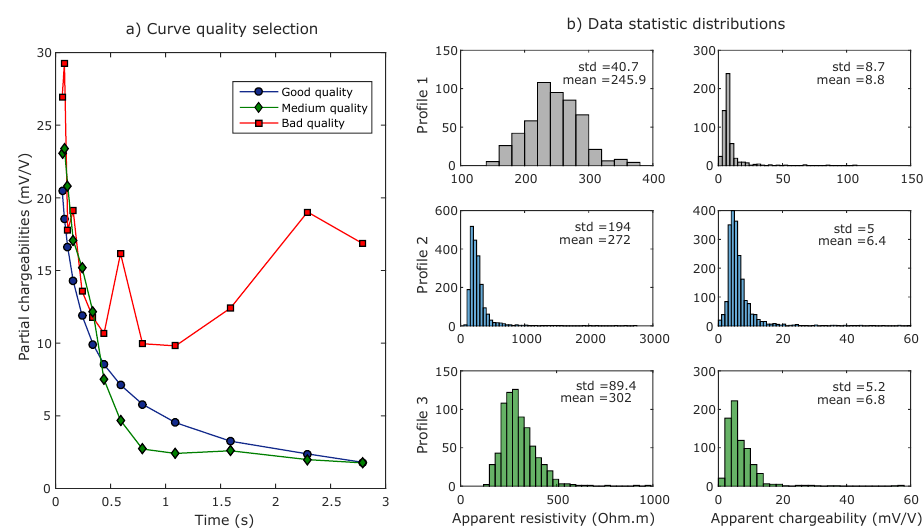
Figure 7. ( a ) Example of three chargeability curves indicating different data quality. The medium quality type of curve is accepted during the filtering but considered as the extreme case. ( b ) Statistical distributions of apparent chargeability and resistivity data for the three profiles. Mean and standard deviation values are indicated for each